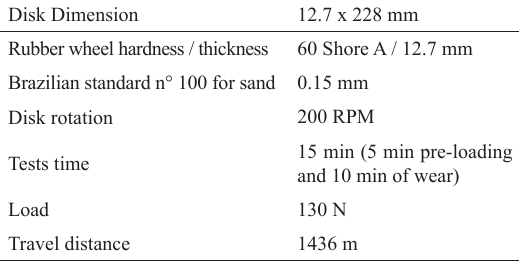
Table 3: Abrasion tests parameters according to the standard ASTM 65-04.